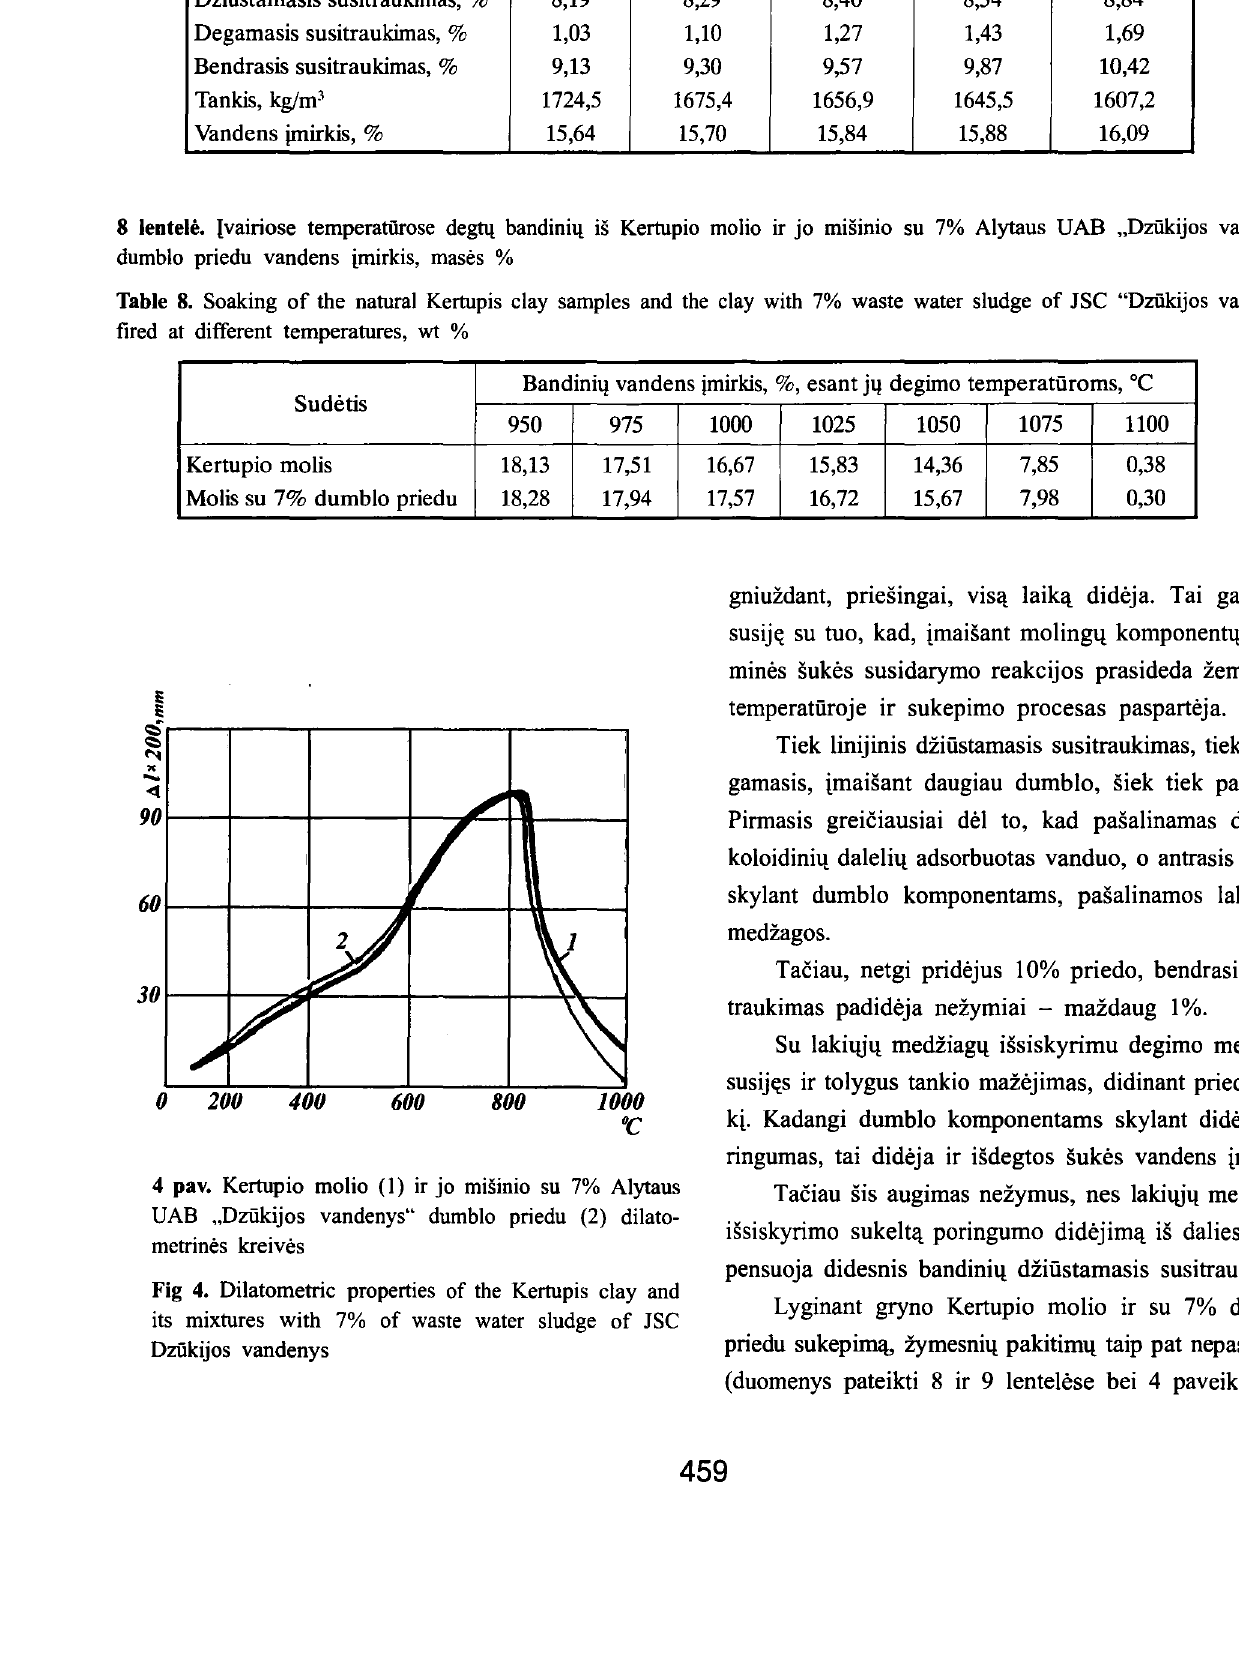
Table 7. Physical and mechanical properties of the samples from Kertupis clay with various amounts of waste water sludge of JSC "Dziikijos vandenys" Rodiklis